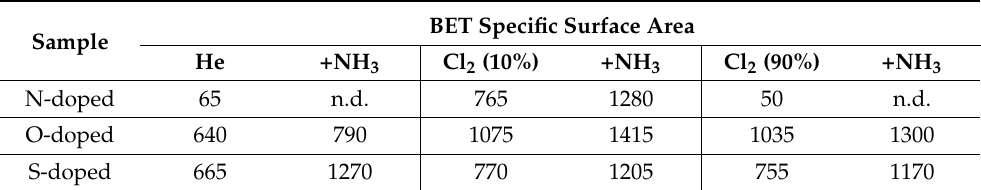
Table 3. Influence of pyrolysis conditions and additional ammonia annealing on the S BET values (m 2 g − 1 ) of the obtained carbon